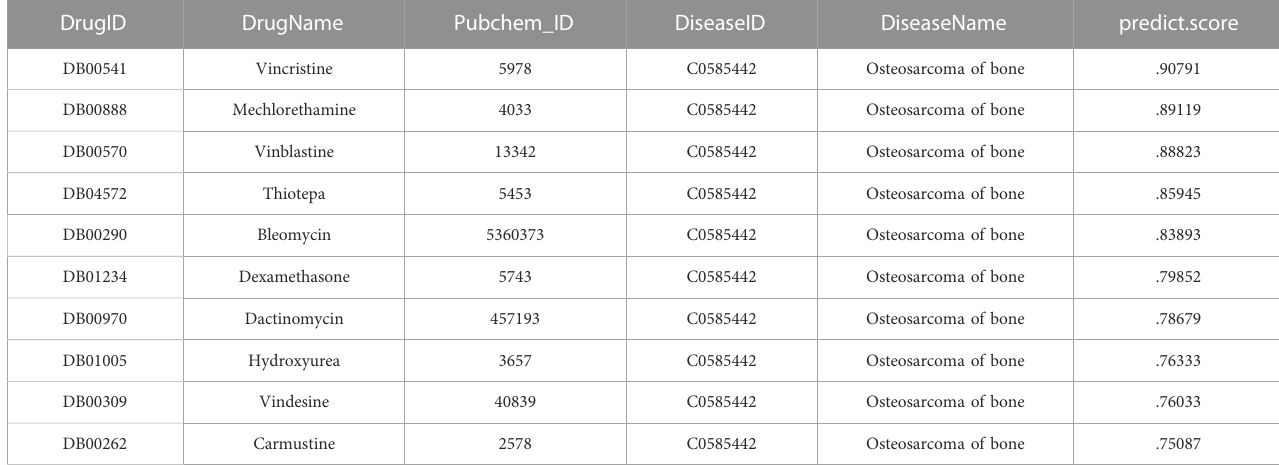
TABLE 1 The top 10 results of predict drugs against OS. DrugID DrugName DiseaseID